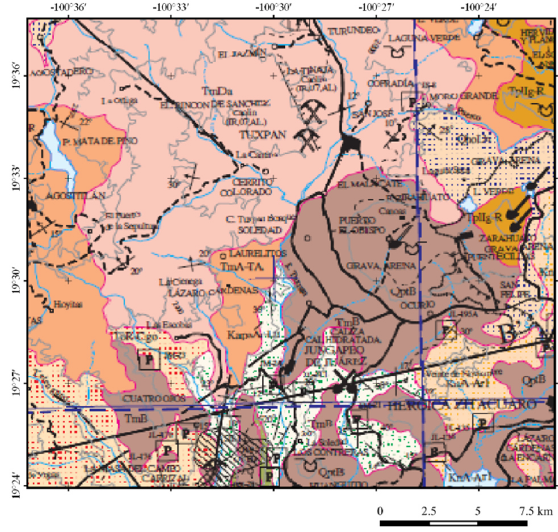
Figure 2 . Geological map (SGM, 1998).